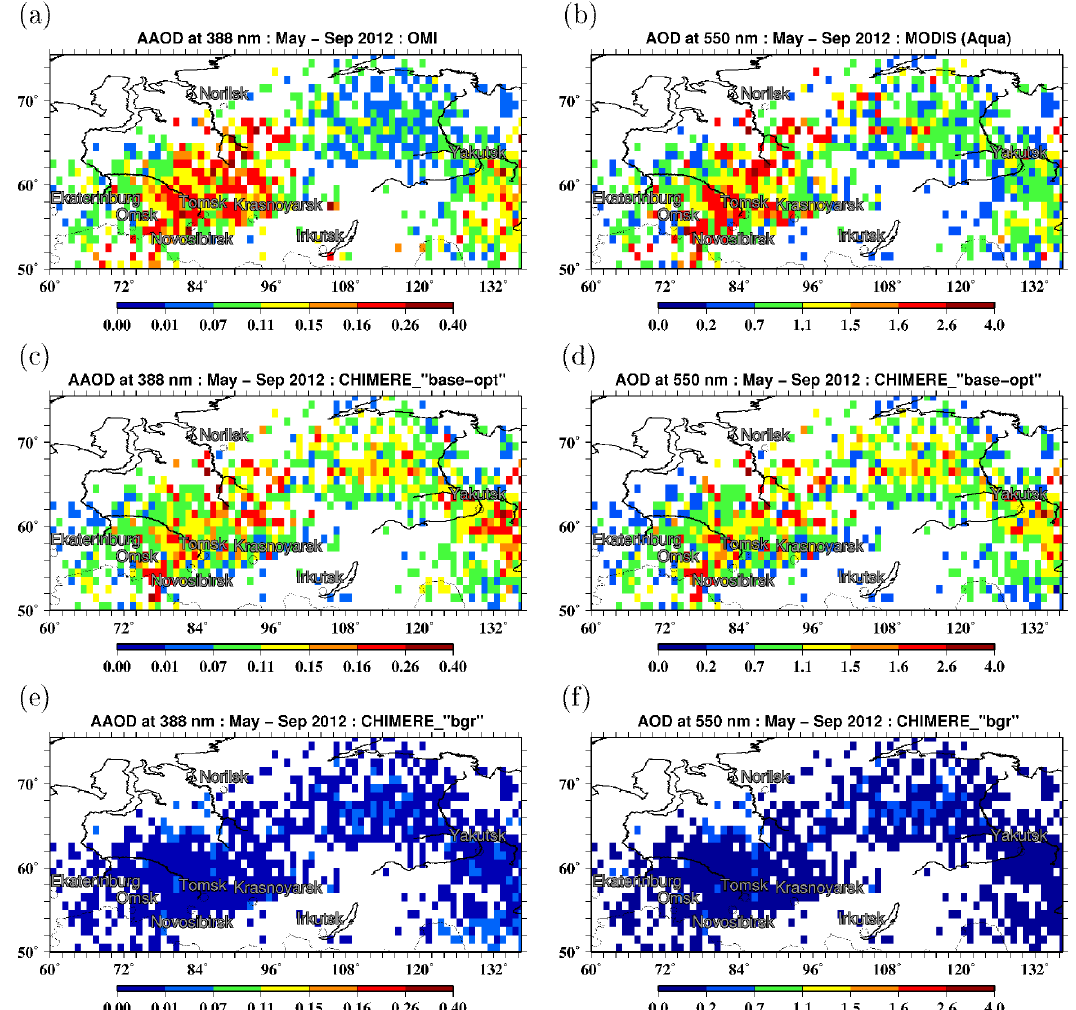
Figure 5. Spatial distributions of the mean values of AAOD at 388nm (a, c, e) and AOD at 550nm (b, d, f) in the period from 1 May to 30 September 2012 according to (a, b) the OMI and MODIS observations, respectively, and simulations performed with the optimized BB emissions (c, d) and without BB emissions (e, f)